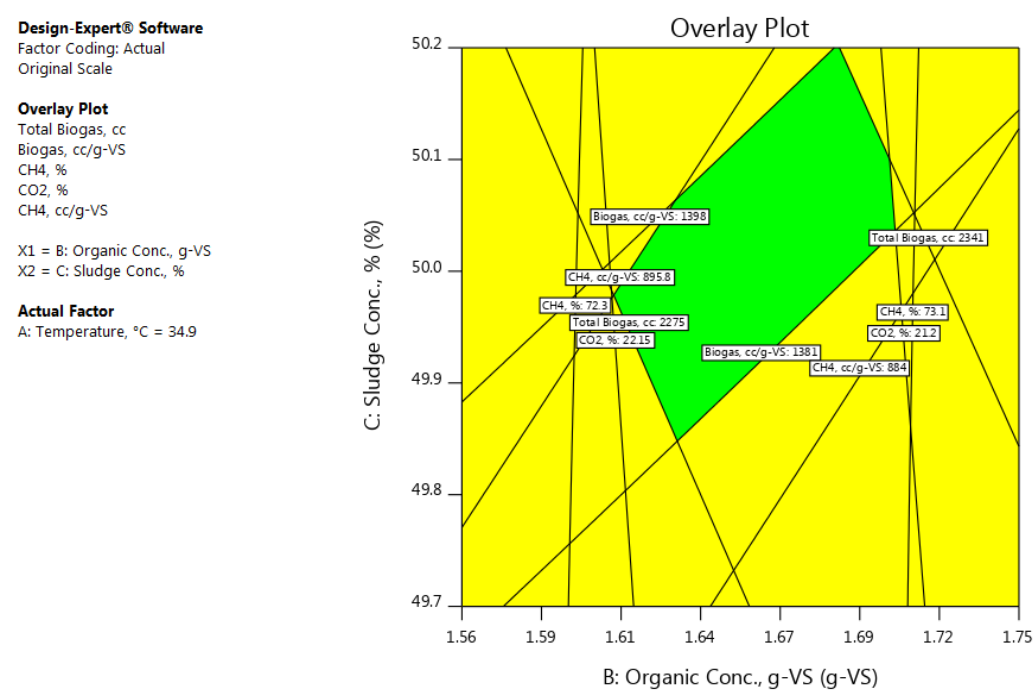
Energies 2020 , 13 , x FOR PEER REVIEW Figure 13. Overlay plot shows the optimum biogas based on the first criterion. Figure 13. Overlay plot shows the optimum biogas based on the first criterion.